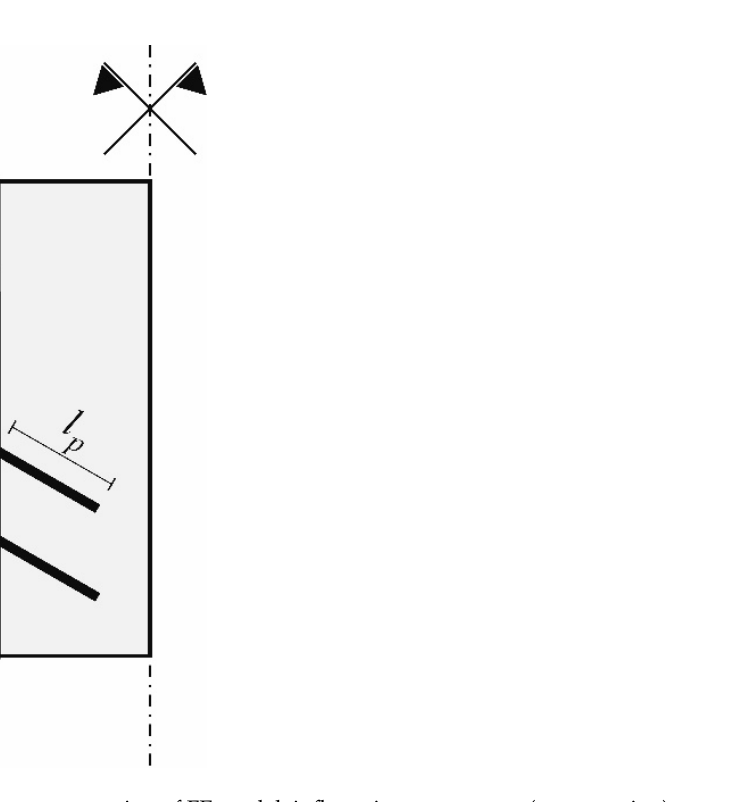
Figure 8. Schematic representation of FE model–influencing parameters (cross-section).